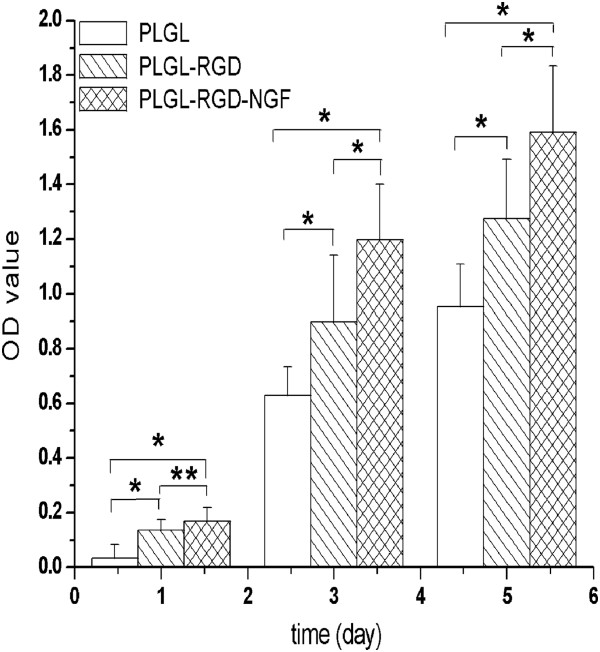
The viability of schwann cells seeded on PLGL, PLGL-RGD and PLGL-RGD-NGF membranes assayed by MTT on days 1, 3 and 5 respectively (*p<0.05, **p > 0.05).